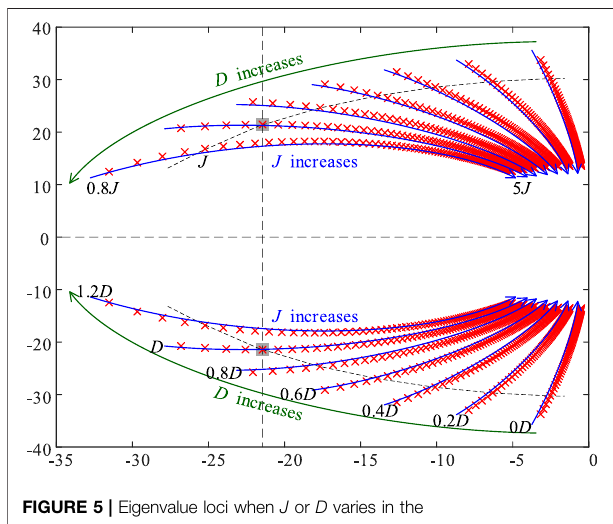
FIGURE 5 | Eigenvalue loci when J or D varies in the underdamping state.